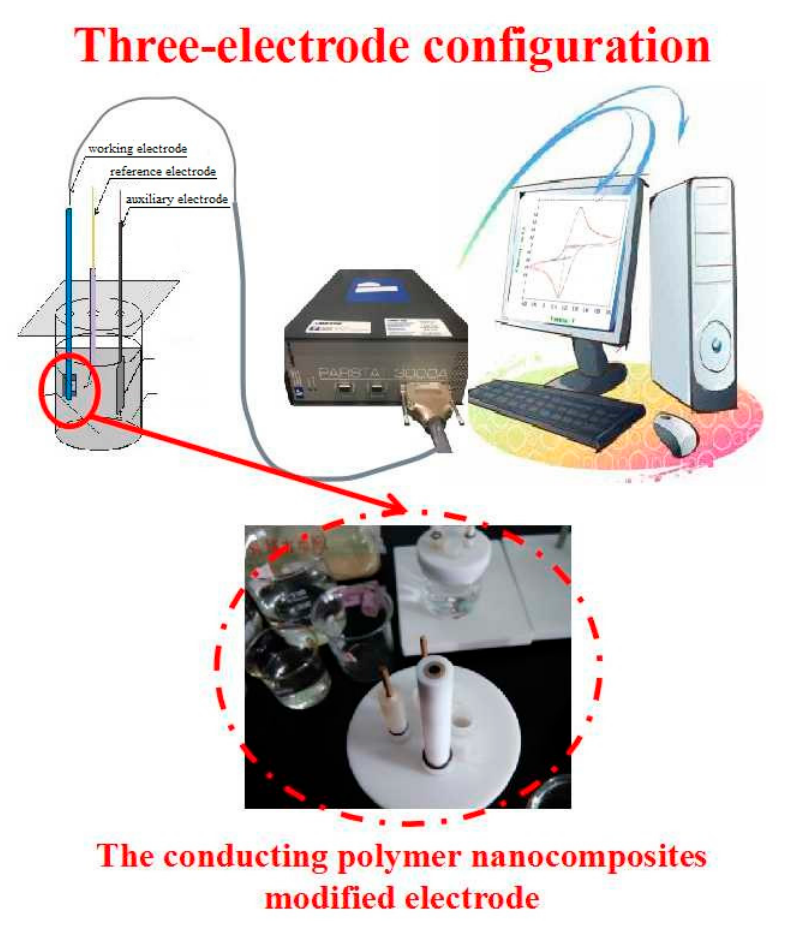
Figure 1. The set-up of the electronic tongue.